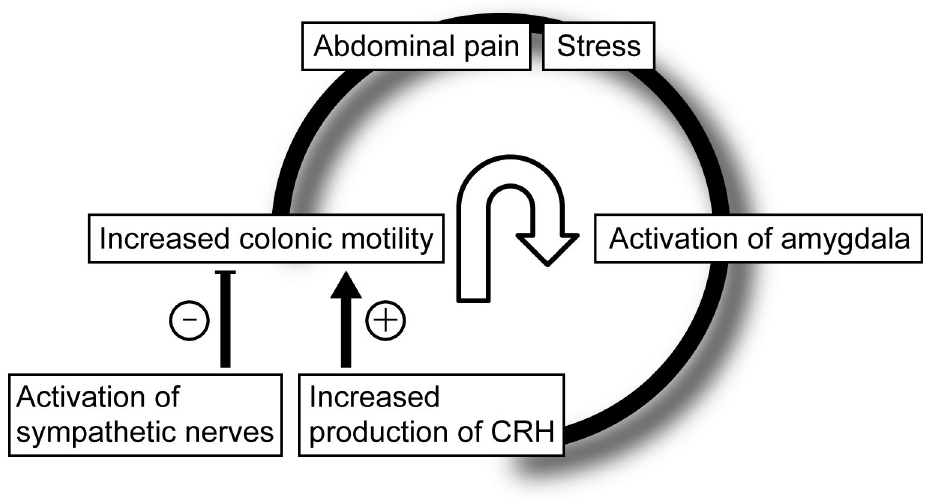
Fig 5. Hypothesized mechanism of exacerbated symptoms and increased sympathetic nerve activity before defecation. The stress of abdominal pain activates the amygdala to release corticotrophin-releasing hormone (CRH), resulting in further exacerbation of abdominal pain by increasing colonic motility. These cascades “exacerbate the circle of pain.” Two minutes before defecation, the stress also activates sympathetic nerves as a stress response against abdominal pain. Increased sympathetic nerve activity can decrease colonic motility, which may have a protective role to hold back the defecation. This situation may be under competition between the accelerator of colonic motility caused by CRH and the brake caused by sympathetic nerve